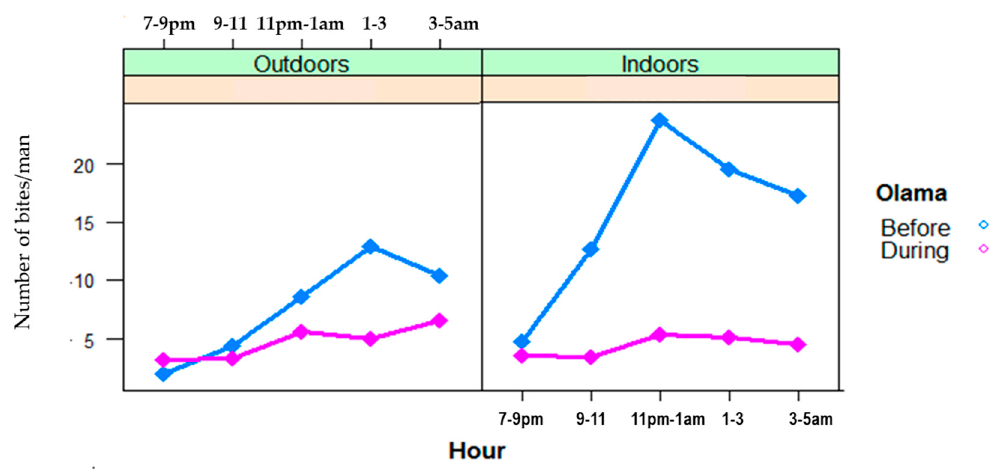
Figure 6. Patterns of A. moucheti hourly biting curves in Olama.